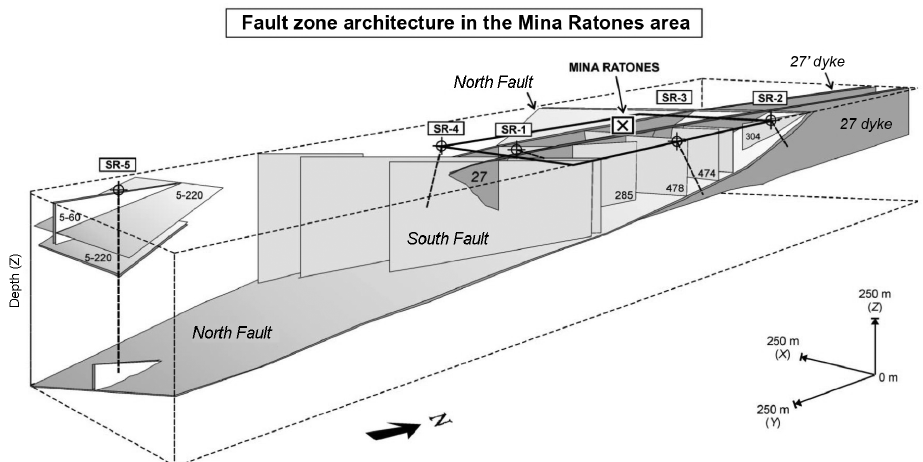
Figure 2. Fault zone architecture of Mina Ratones area obtained from structural, seismic, core, and well log data (Escuder-Viruete and Perez-Estaun, 1998; Carbonell and Pérez-Estaún, 1999; Escuder-Virutete, 1999; Pérez-Estaún, 1999; Escuder-Viruete et al., 2001). The main identified structures are the North Fault (NF), the South Fault (SF), and the 27 and 27’ dykes. Other relevant brittle structures of minor size are faults 474 and